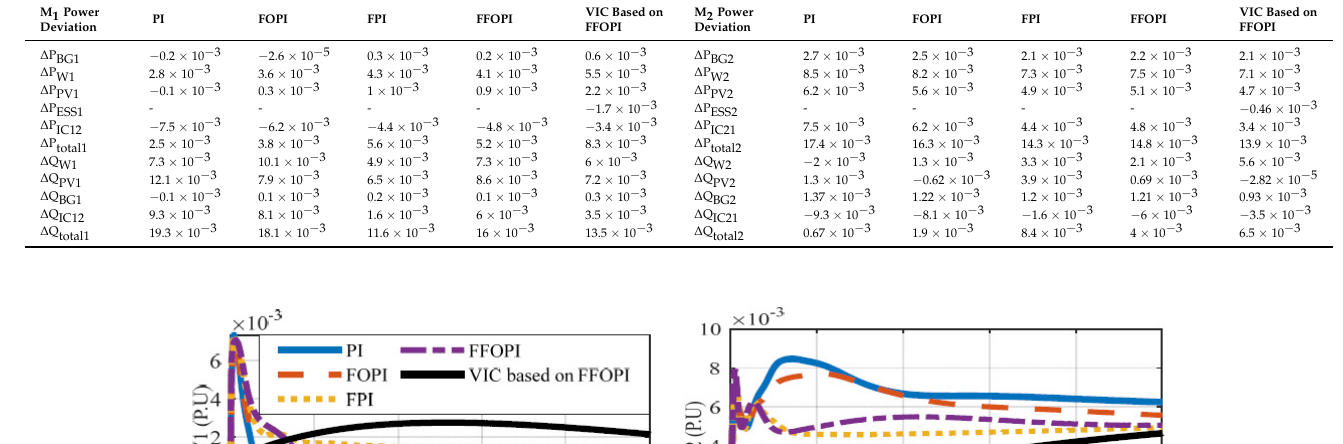
Table 11. Power flow in pu of microgrid system M 1 and M 2 for each controller at wind speed disturbance.